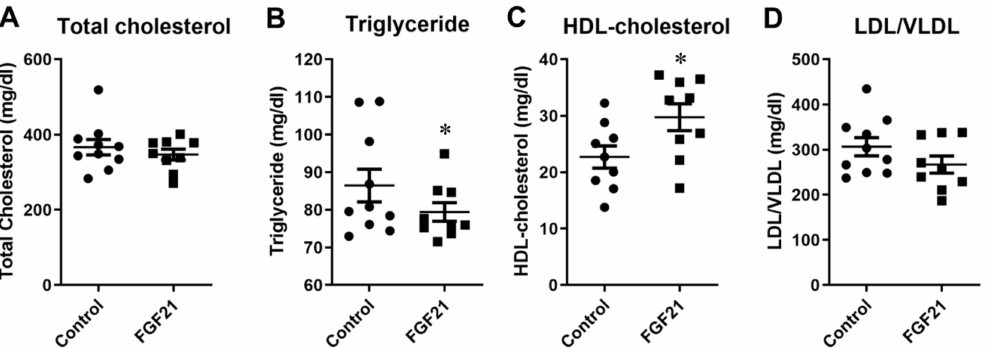
Figure 2. Changes in lipid profiles after 5 weeks of treatment with normal saline as control and fibroblast growth factor 21 (FGF21; 0.1 mg / kg) in the ApoE − / − mice. ( A ). total cholesterol, ( B ). triglyceride, ( C ). HDL-cholesterol, ( D ). LDL / VLDL. * p < 0.05 vs. control.